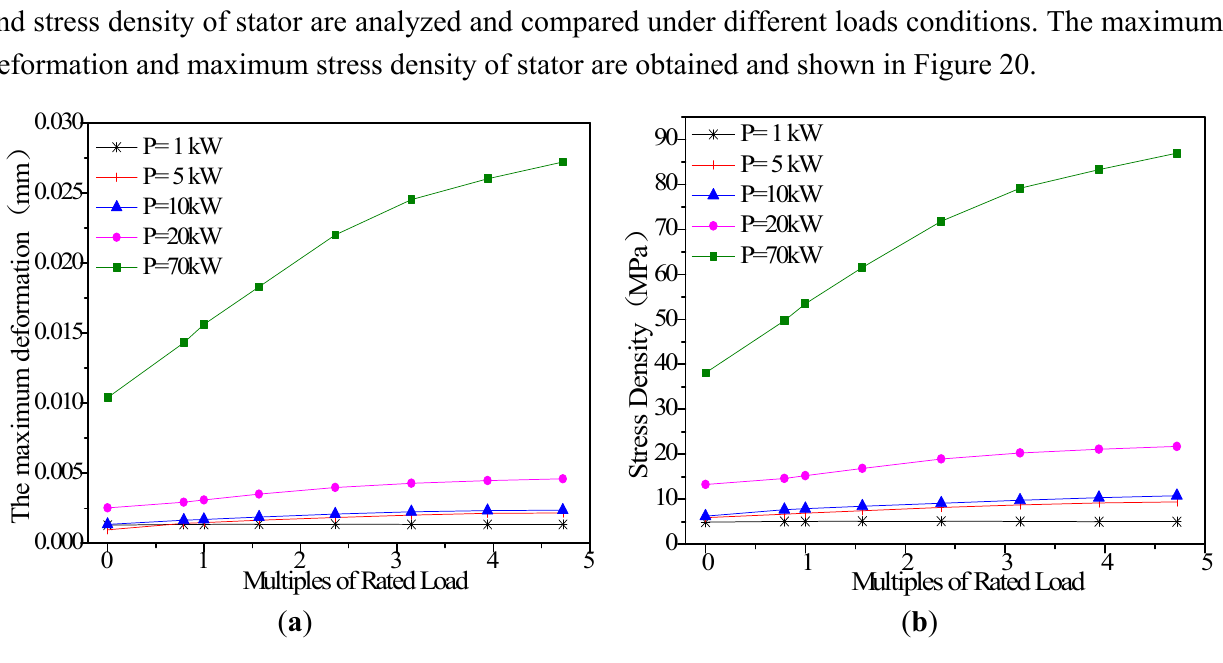
Figure 20. The stator of five different power level DRPMSMs: ( a ) deformation; and ( b ) stress